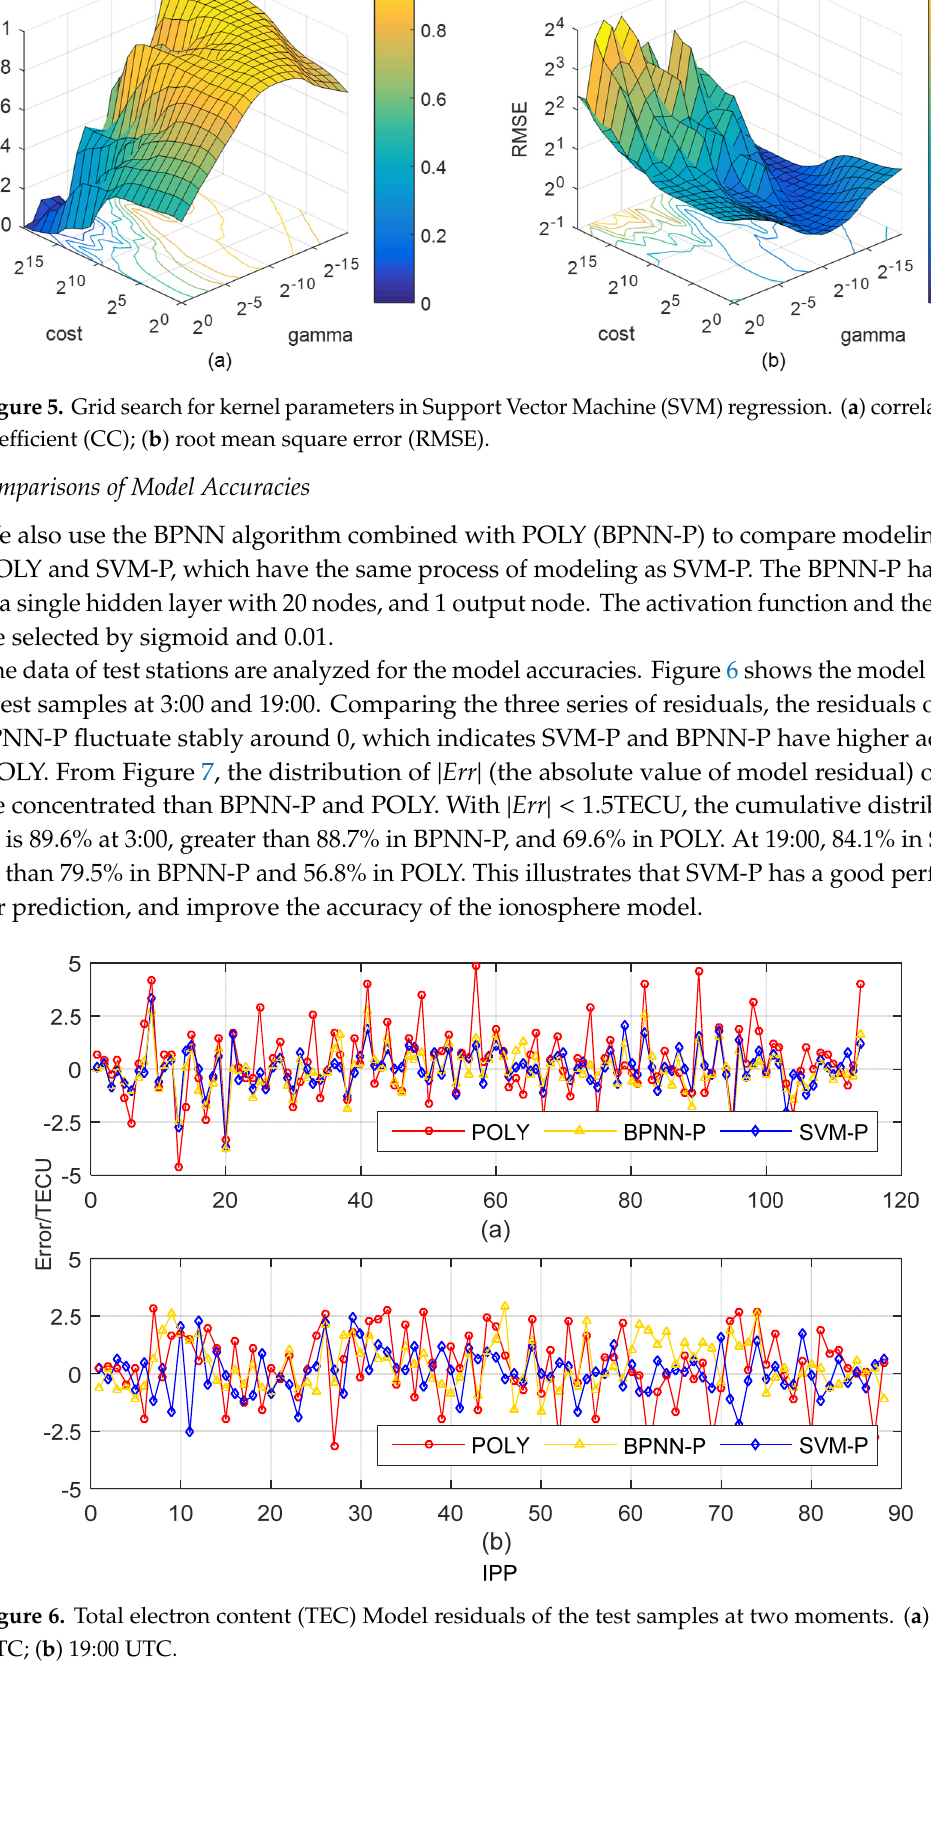
Figure 7. Residuals distribution statistics. (a) , (b) , (c) Residuals of polynomial (POLY), back propagation neural network combined with POLY (PBNN-P), and Support Vector Machine Polynomial (SVM-P) at 3:00 UTC with 115 samples. (d) , (e) , (f) Residuals of POLY, PBNN-P, and SVM- P at 19:00 UTC with 88 samples. The data of test stations are analyzed for the model accuracies. Figure 6 shows the model residuals of the test samples at 3:00 and 19:00. Comparing the three series of residuals, the residuals of SVM-P and BPNN-P fluctuate stably around 0, which indicates SVM-P and BPNN-P have higher